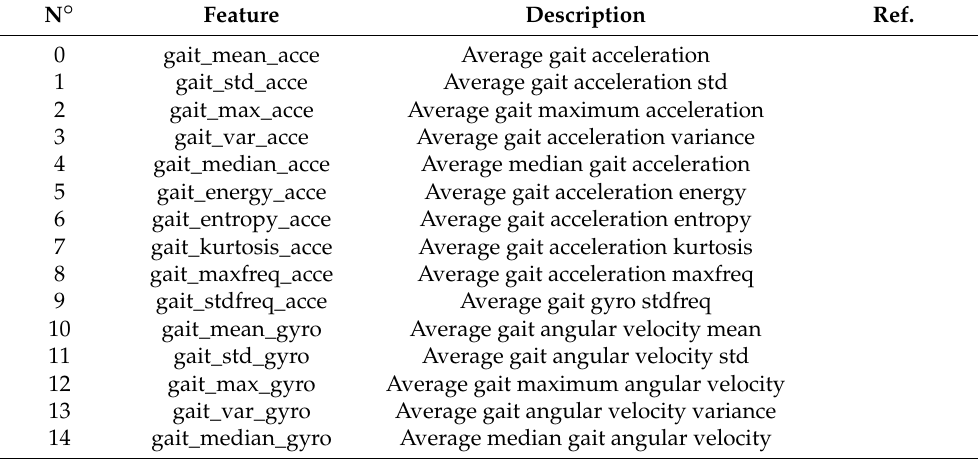
Table 4. Features